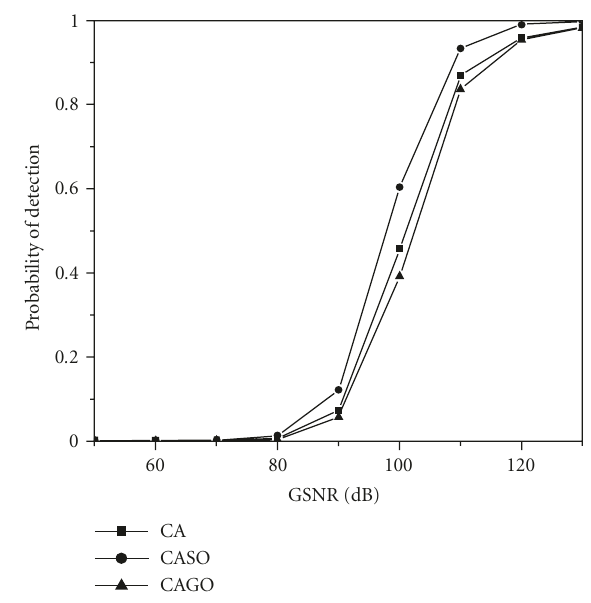
Figure 4: Probability of detection of CA, CAGO, and CASO CFAR processors in homogeneous Pearson background and in presence of three interfering targets (GINR 1 = GINR 2 = GINR 3 = 50 dB) as a function of GSNR. Reference window size is N = 32. P CA P CAGO = P CASO = 10 − 4 fa fa